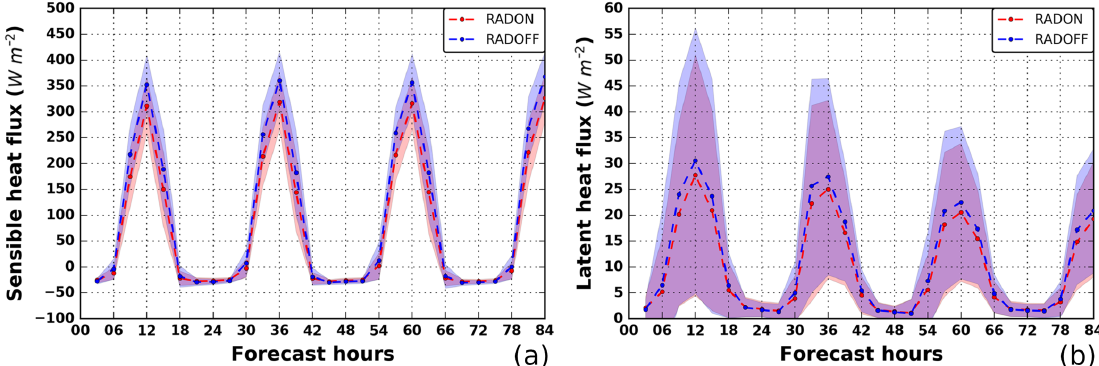
Figure 6. Regional averaged values, over land areas of the simulation domain affected by dust loads, of the (a) sensible and (b) latent heat fluxes, expressed in watts per square metre (Wm − 2 ), based on the RADON (red) and the RADOFF (blue) configuration of the NMMB- MONARCH model. The dashed lines correspond to the mean values calculated by the 20 simulated Mediterranean desert dust outbreaks and the shaded areas represent the associated standard